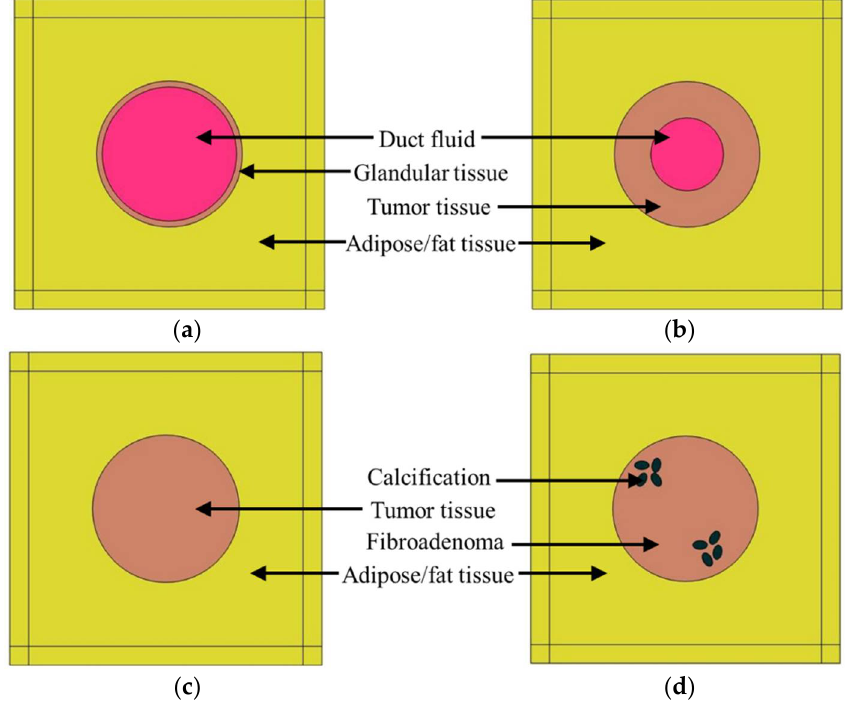
Figure 1. Breast duct models for the DOS, ( a ) normal duct, ( b ) ductal hyperplasia (ADH), ( c ) duct with DCIS, ( d ) duct with calcification.